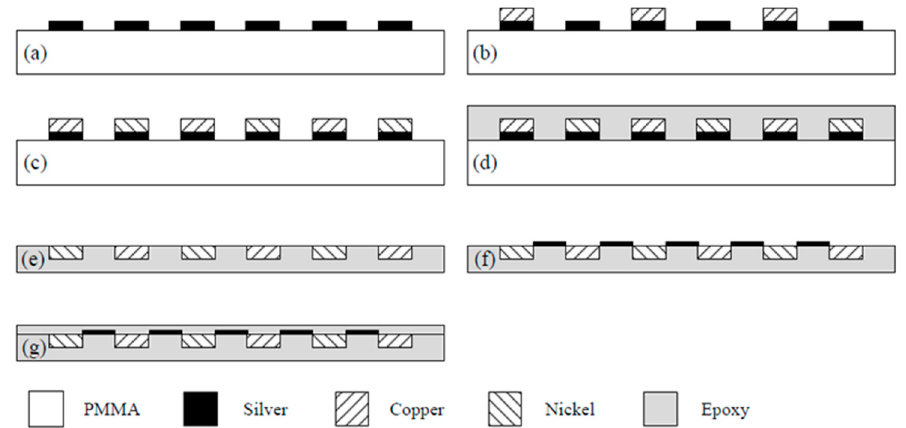
Figure 4. Process flow for a flexible thermoelectric generator: ( a ) Defining a silver seed layer; ( b ) electroplating copper; ( c ) electroplating nickel; ( d ) coating epoxy polymer; ( e ) etching polymethyl methacrylate substrate; ( f ) painting silver; ( g ) packaging.